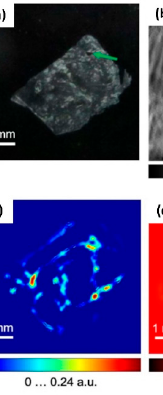
Figure 14. Two datasets corresponding to different tissue samples. Photographs of normal and cancerous colon tissue and cross-polarised THz image. “N” and “C” represent normal and cancerous respectively: ( a , d ) Photographs of normal and cancerous colon tissue; ( b , c ) The cross-polarised THz image of the normal and cancerous colon tissue. Reproduced from [41] CC BY 4.0.